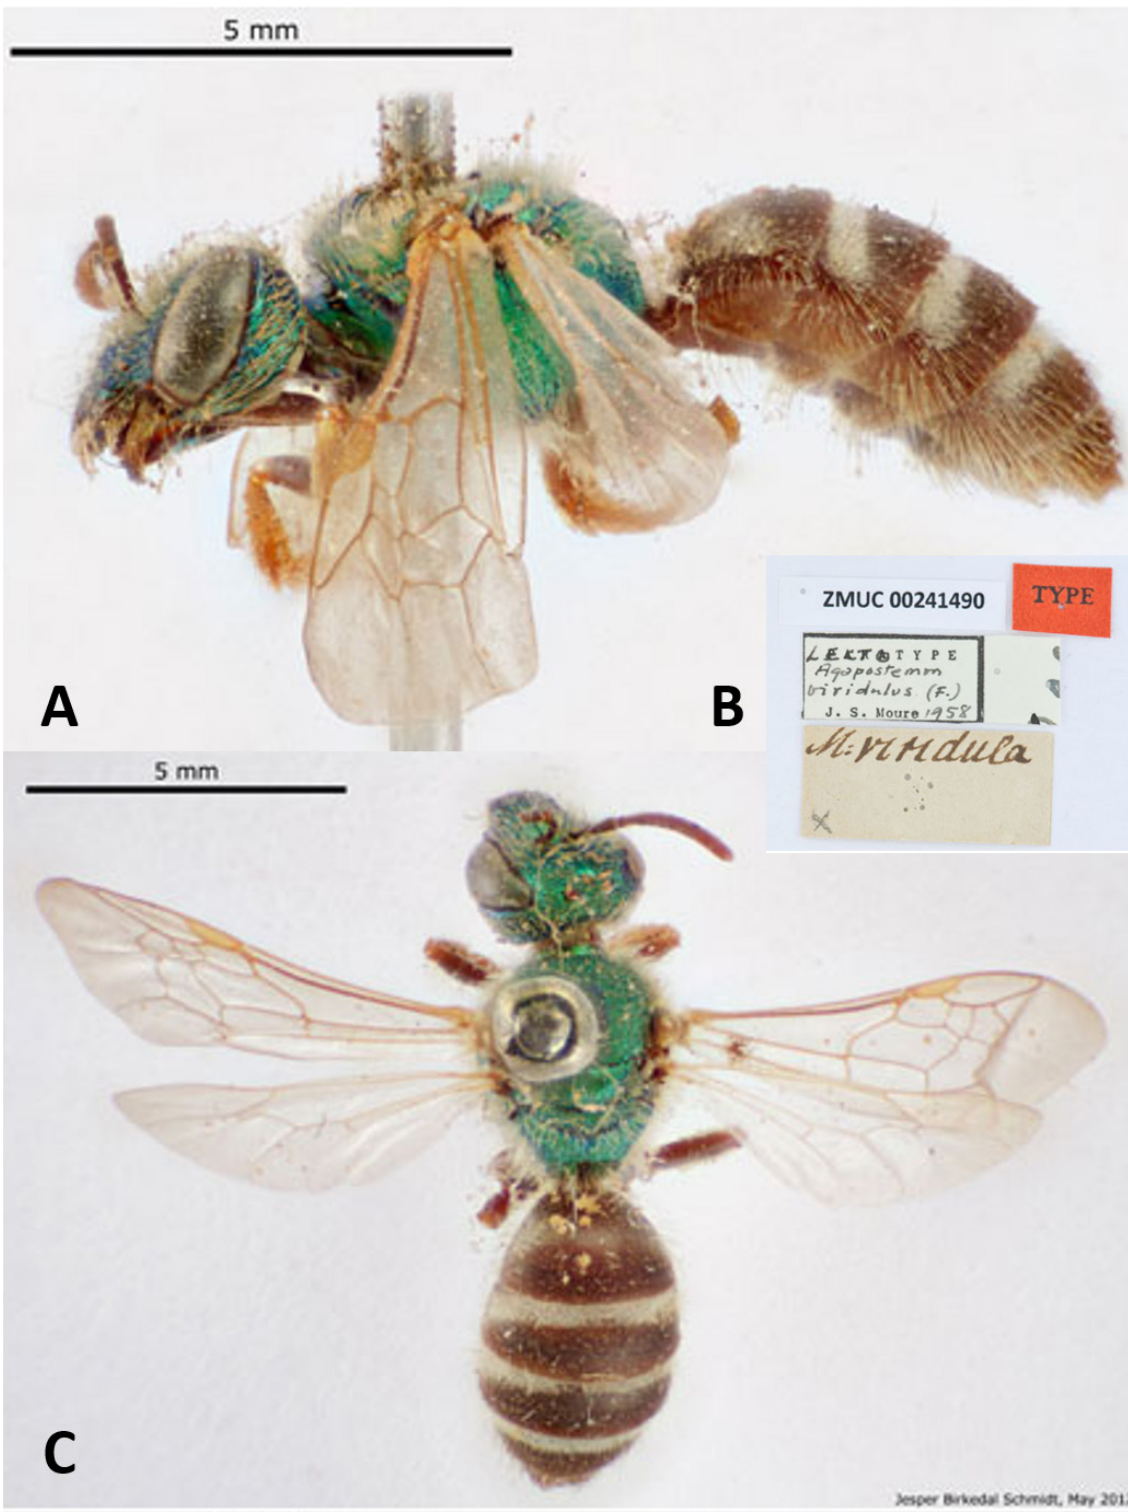
Fig. 2. Apis viridula Fabricius, 1793. Lectotype, ♀ (NHMD ZMUC00241490). A . Lateral view. B . Associated labels. C . Dorsal view. Photos by Jesper Birkedal Schmidt, Natural History Museum of Denmark [digitized assets